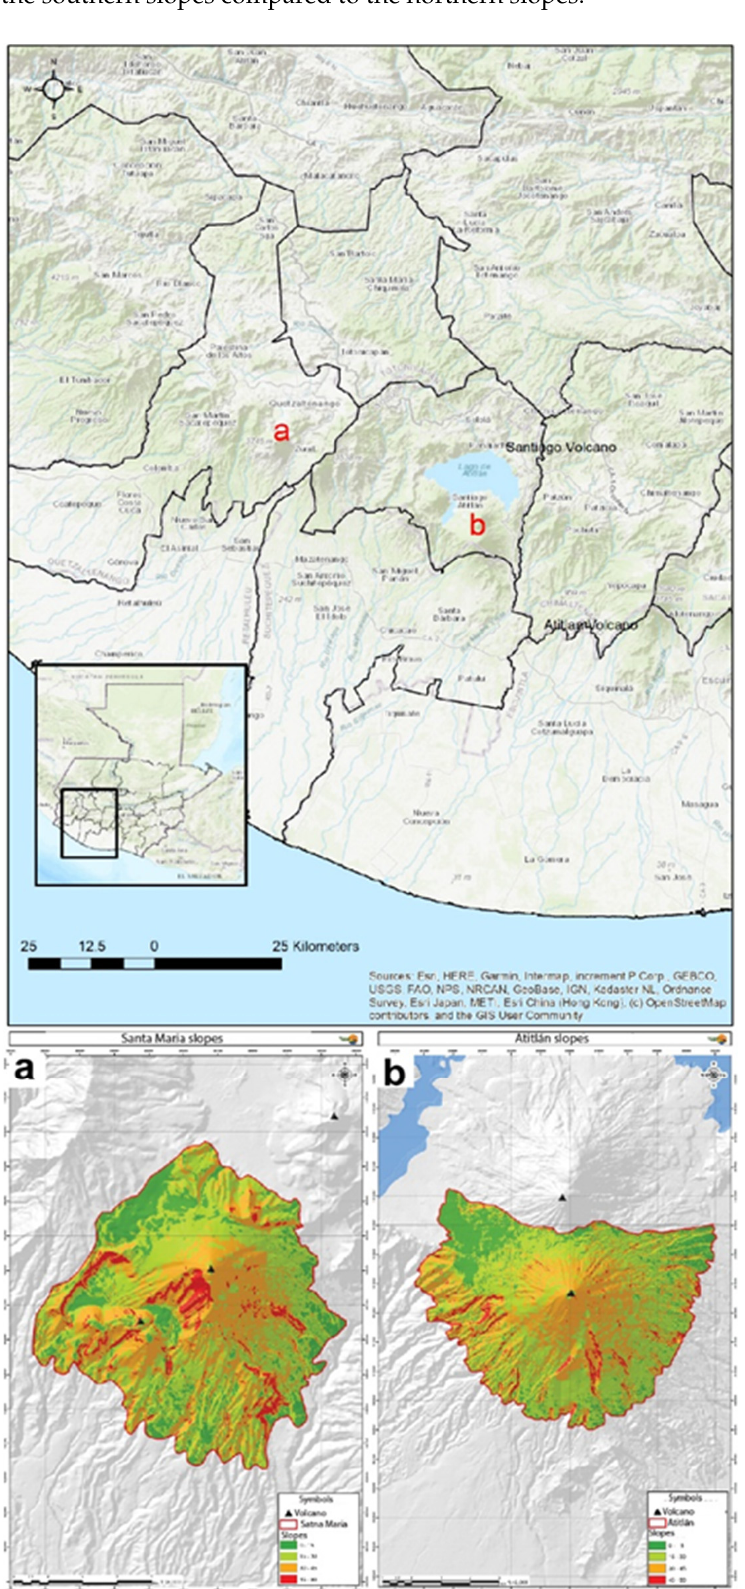
Figure 1. Map of the Southern Guatemalan Volcanic Chain and slope profile for the ( a ) Santa Maria and ( b ) Atitlan volcanoes.